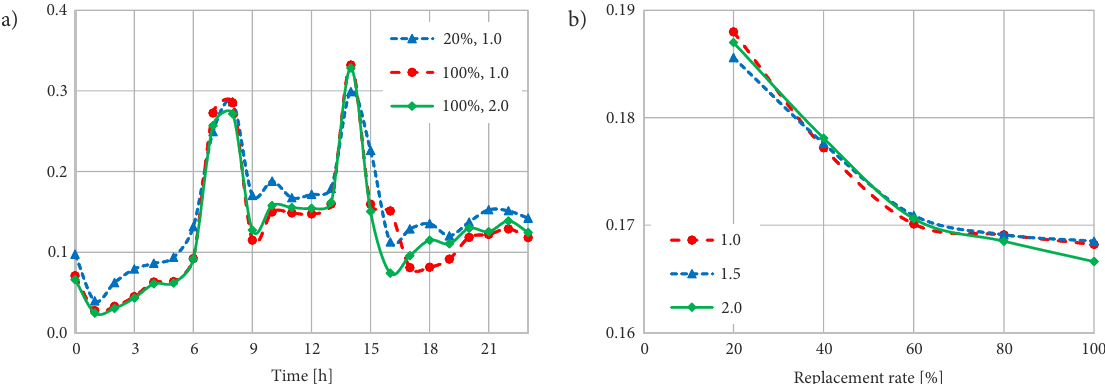
Figure 8. AT empty drive ratios: a – hourly averages for selected simulation cases; b – daily